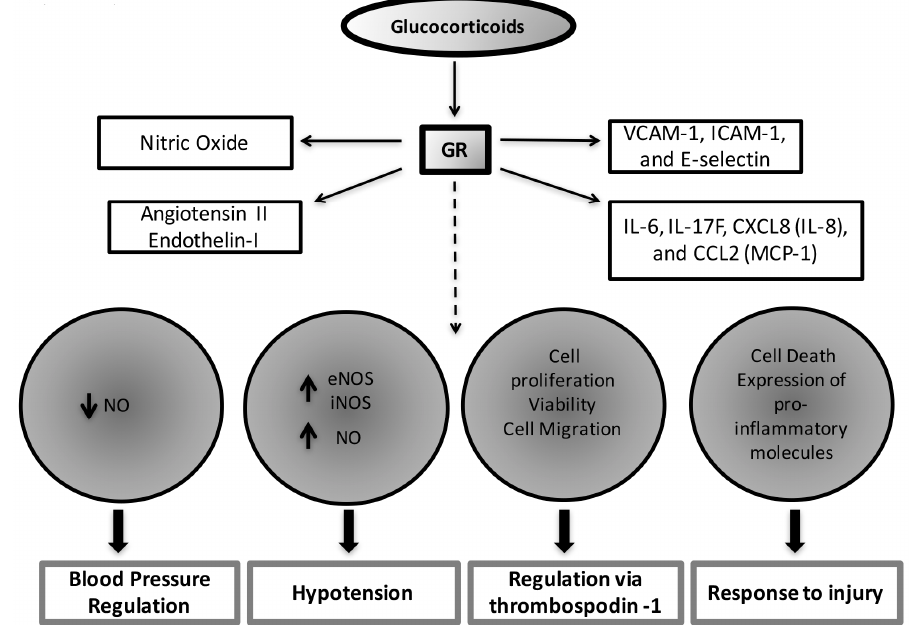
Figure 2. The direct and indirect effects of glucocorticoids on the vascular endothelium. glucocorticoids, through glucocorticoid receptors (GRs), regulate the expression of molecules critical to maintain the endothelium structural and functional properties. Among these molecules are adhesion molecules (VCAM-1, ICAM-1 and E selectin), pro-inflammatory cytokine and chemokine production (IL-6, IL-17F, CXCL8 (IL-8), and CCL2 (MCP-1)), vasodilators nitric oxide and vasoconstrictors angiotensin II and endothelin I [54–59]. Via the regulation of these mediators, GR exerts effects on blood pressure regulation, endothelial cell proliferation, viability, migration, cell death and the expression of inflammatory mediators in response to injury or infection. Dashed arrow: Effects of GR on the vasculature; Up arrow: up-regulation; Down Arrow: down-regulation.